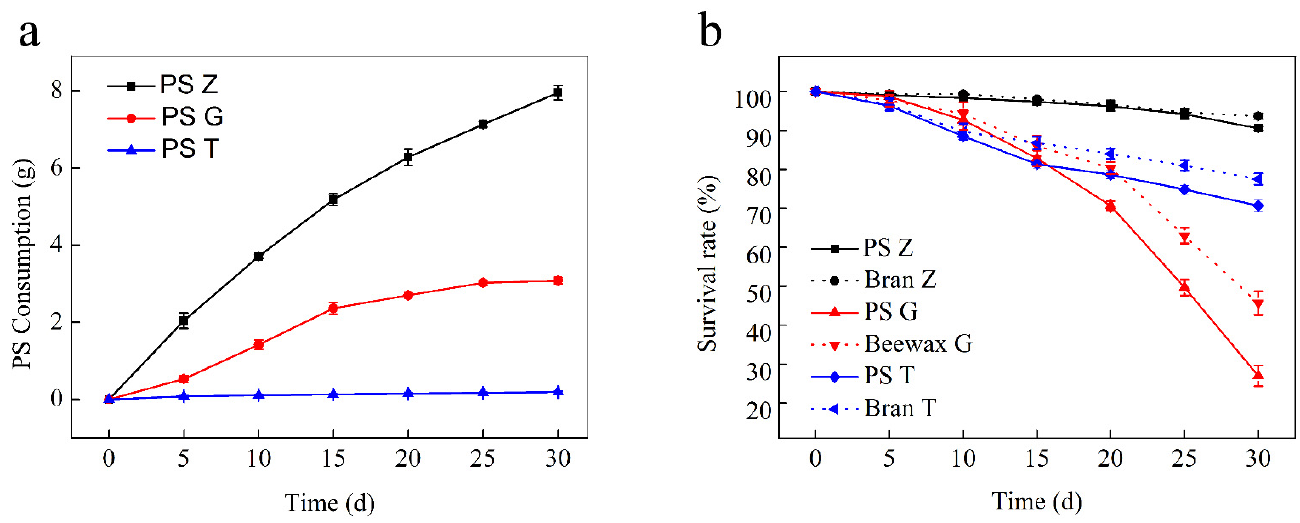
Figure 1. PS consumption by superworms, greater wax moths, and yellow mealworms ( a ), the survival rate for the three species’ larvae that were fed with PS and bran/beeswax ( b ). Z: superworms, G: greater wax moths, T: yellow mealworms. Aftertheexperiment,theweightchangesofthePSgroupwere − 51.67 ± 1.15%, − 43.61 ±